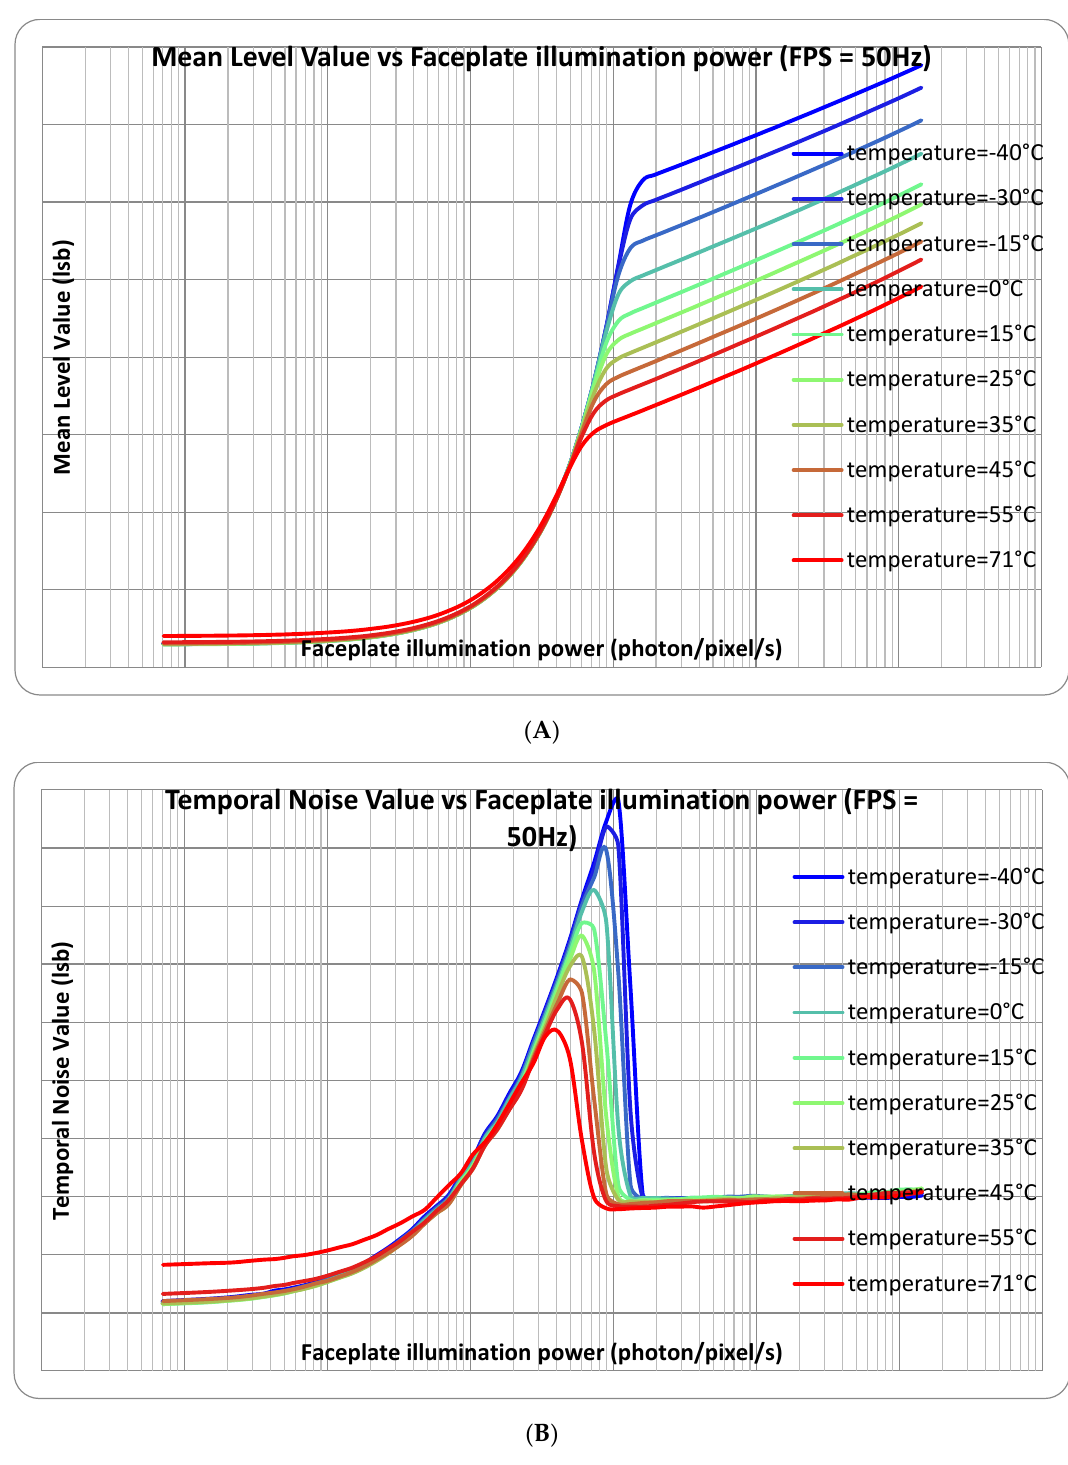
Figure 8. Measured responses ( A ) and temporal noises ( B ) from the test chip at 50 Hz with different temperatures.